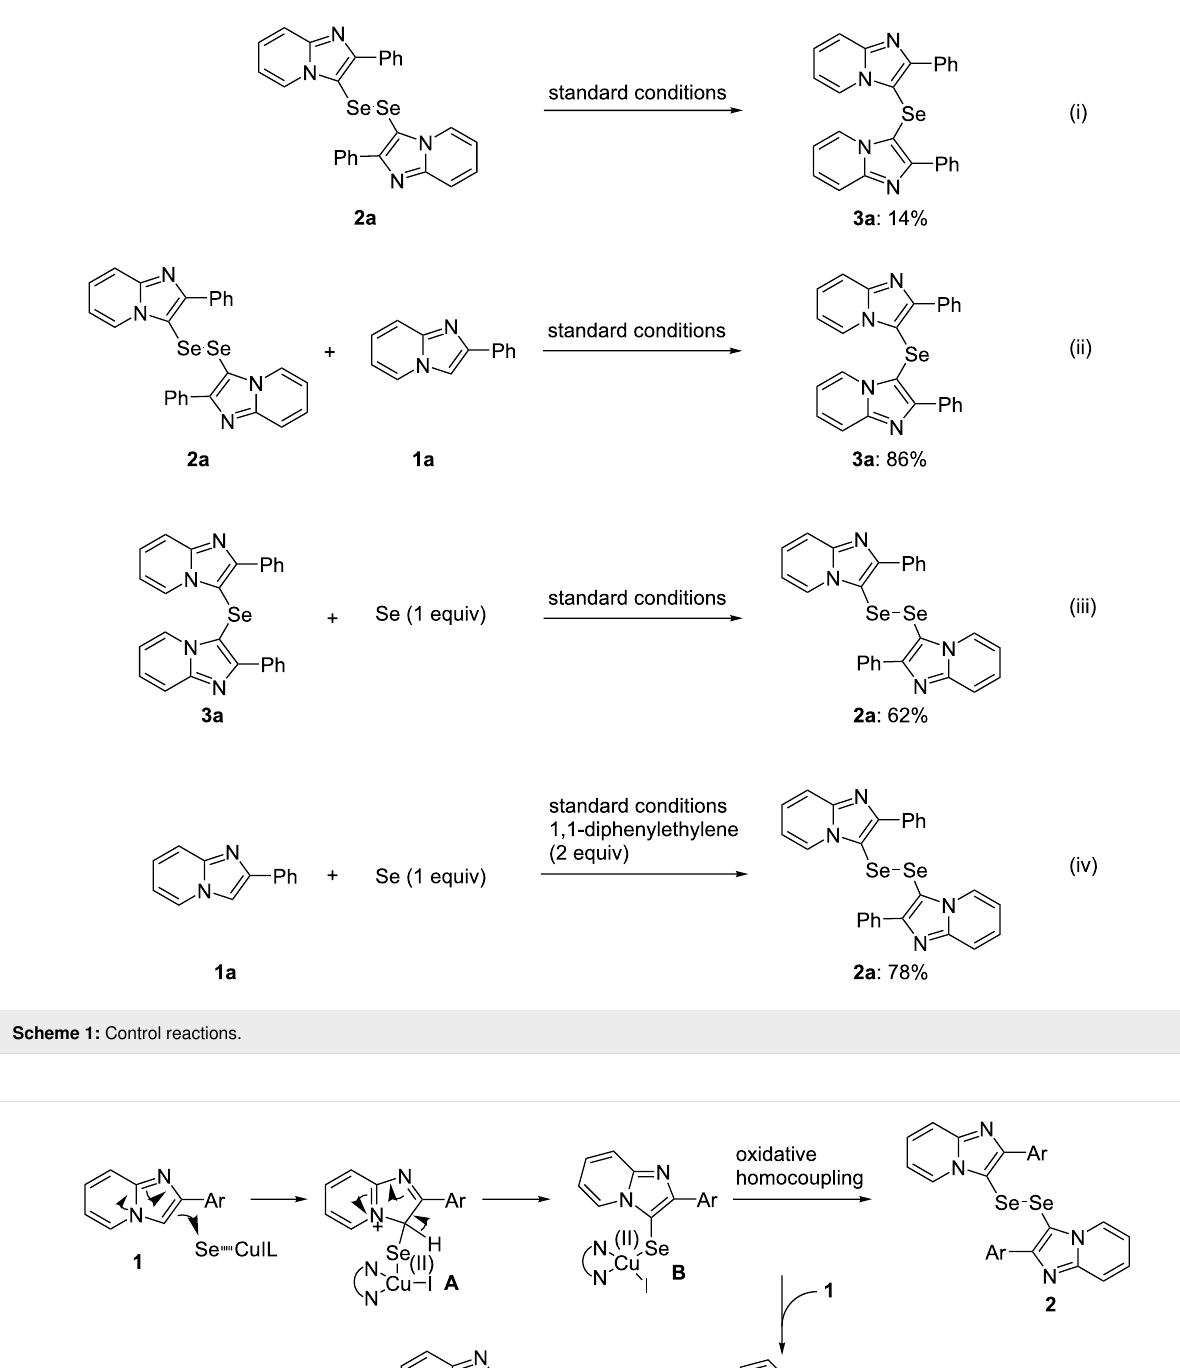
Scheme 2: Proposed mechanism